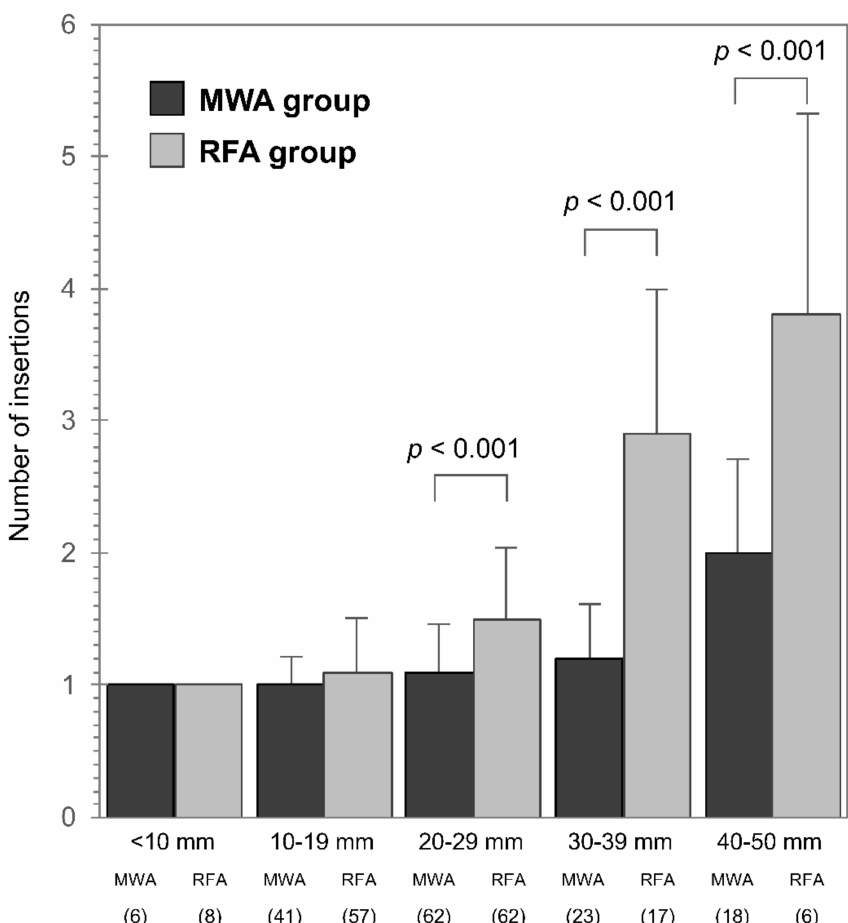
Figure 4. Total number of insertions according to tumor size. There was no significant difference in the total number of insertions for tumors that were sized <19 mm, although significantly fewer insertions were required for tumor sizes of >20 mm in the MWA group ( p < 0.001). MWA, microwave ablation; RFA, radiofrequency